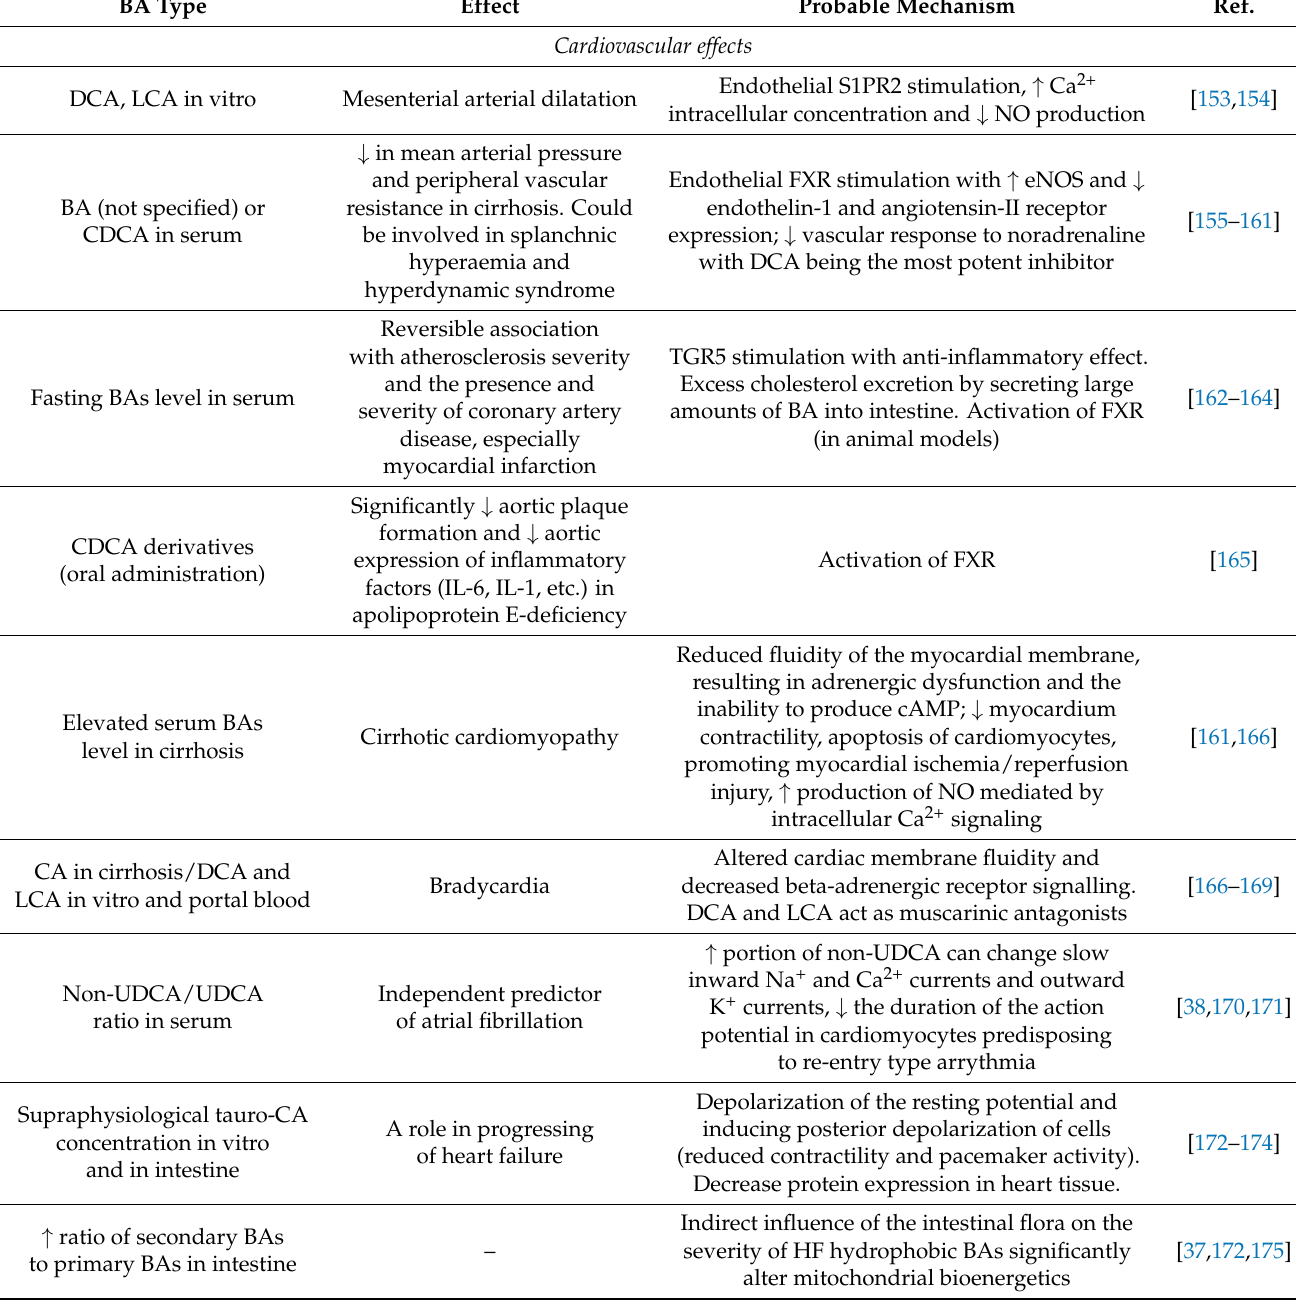
Table 1. The role of bile acids in biological processes associated with the development of